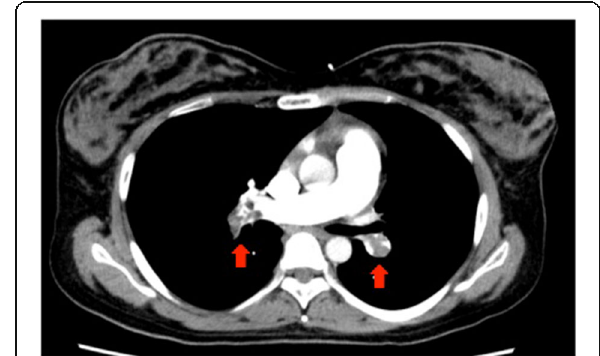
Fig. 1 Contrast-enhanced computed tomography of the chest on admission. Red arrows show thrombi occupying the pulmonary arteries bilaterally